Question: What caption would you write for this figure?
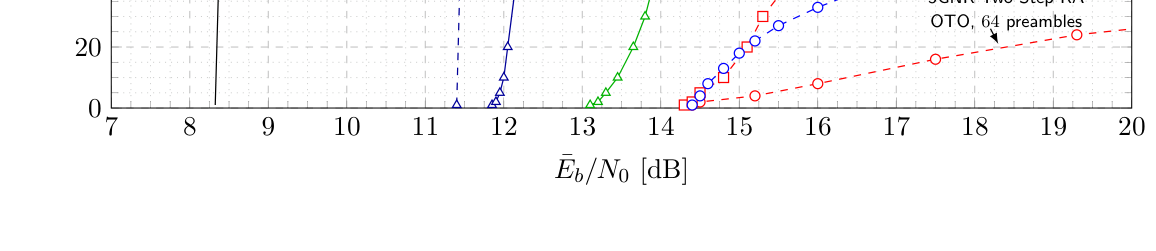
Answer: Number of supported active users vs. average SNR for a target PUPE = 10−1. Quasi-static Rayleigh fading channel, n ≈20000 channel uses. Single antenna at the base station.